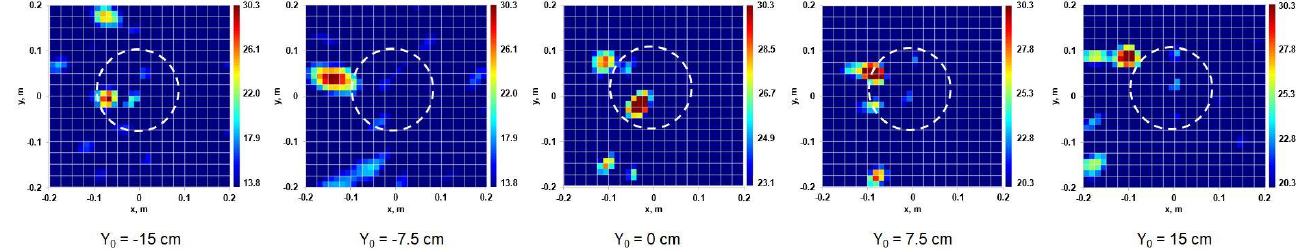
Figure 24. Results of multi-view holographic sensing of a metal disk, buried in the road bed.